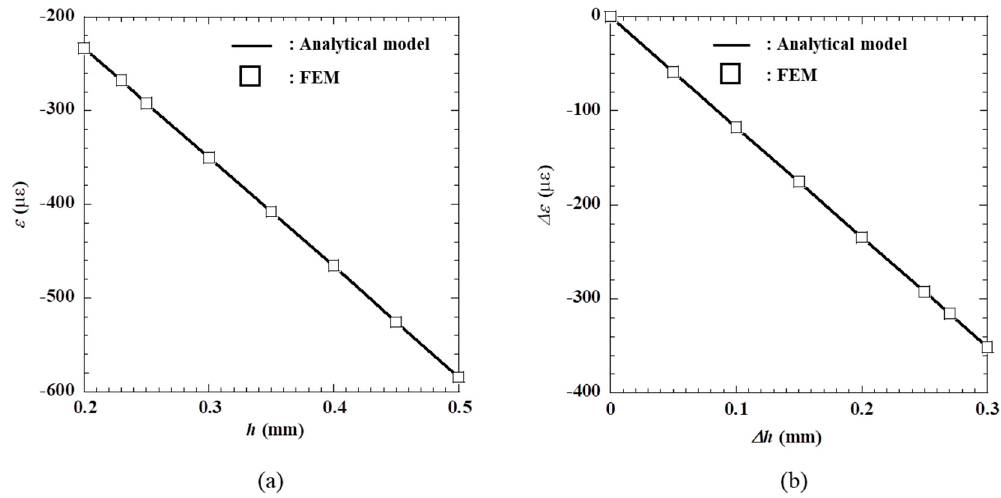
Figure 8. ( a ) Relationship between the strain ( ε ) and thickness of the test piece ( h ) from FEM simulations. ( b ) Relationship between the change in strain ( ∆ ε ) and change in thickness ∆ h in mm from FEM simulations. The analytical model provides the line of best fit in both plots.